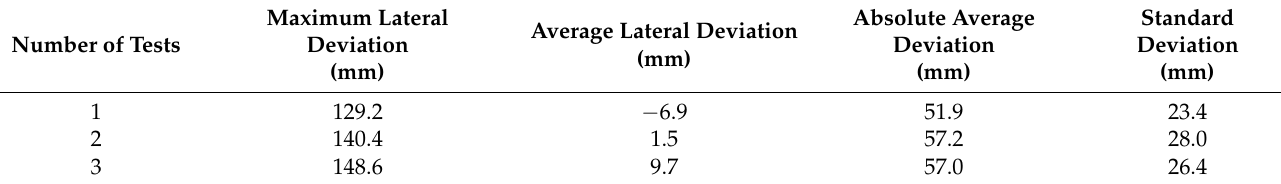
Table 14. Statistics of straight-line path lateral deviation . Table 15. Statistics of U-shaped path lateral deviation.